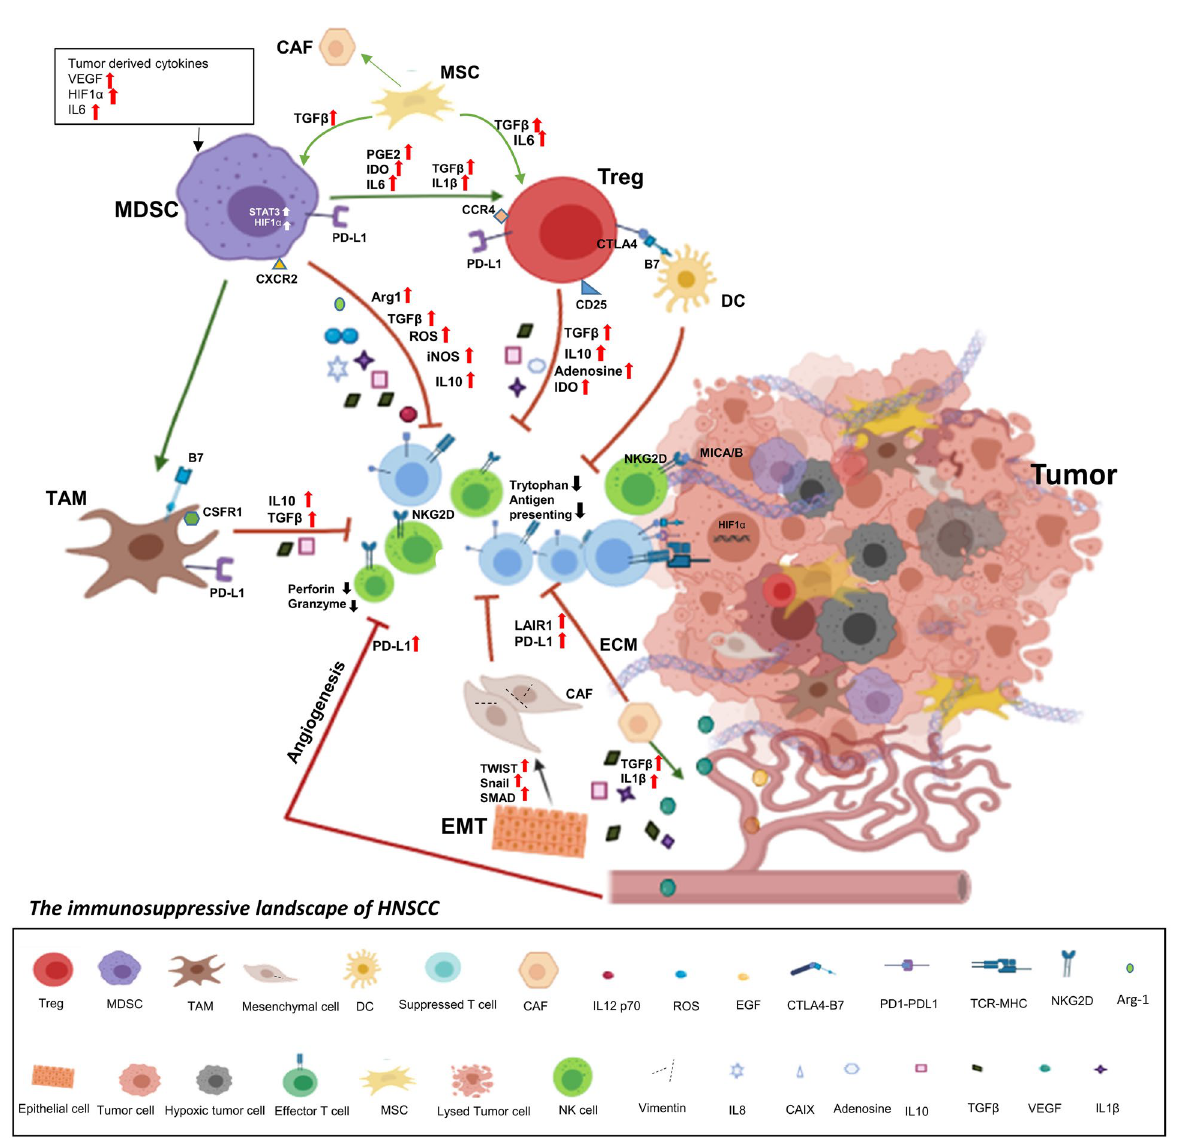
Figure 1. The immunosuppressive landscape of HNSCC. Various tumor-derived factors and hypoxia recruit immune suppressive cells including MDSCs, Tregs, CAFs, MSCs, and TAMs to the tumors. These immune suppressive cells secrete several pro-tumor factors like TGF-β, PGE , Arg-1, IL-6, iNOS, IL-10, and IDO. In addition, high expression of adenosine, PD-L1, and CTLA4 on the 2 immune suppressive cells results in dampening of the anti-tumor effector functions of the immune cells in the TME. Hypoxia, tumor intrinsic factors, like ROS, ECM, and EMT form a physical barricade, hindering the infiltration of immune cells. These factors also favor the proliferation of immune suppressive cells which decrease the proliferation and anti-tumor effector functions of tumor- infiltrating immune cells including NK cells and CTLs. Induction of neoangiogenesis leads to increased migration of tumor cells resulting in metastasis. In addition, VEGF induces PD-L1 expression on MDSCs reducing T cell activation Increased mesenchymal cells in the tumor, as a result of EMT, also express the immune check-points along with the secretion of immunosuppressive factors like TGF-β. Thus, either directly or in a combination, the tumor intrinsic factors and the recruited non-malignant host cells aid tumor immune evasion in HNSCC. HIF: hypoxia-inducible factors; CAF: cancer-associated fibroblast; CXCR: C-X-C motif chemokine receptor; MSC: mesenchymal stem cell; PGE : prostaglandin E ; IDO: indoleamine 2,3-dioxygenase; B7: B7 family proteins; 2 2 iNOS: inducible nitric oxide (NO) synthase; Arg 1: arginase 1; CSFR1: colony-stimulating factor receptor 1; NKG2D: Natural Killer Group 2D receptor; TWIST: twist transcription factor; SMAD signal transducers for receptors of the TGF-β superfamily; an acronym from the fusion of Caenorhabditis elegans Sma genes and the Drosophila Mad, (Mothers against decapentaplegic); TCR: T cell receptor; CAIX: carbonic anhydrase IX; VEGF: vascular endothelial growth factor; ECM: extracellular